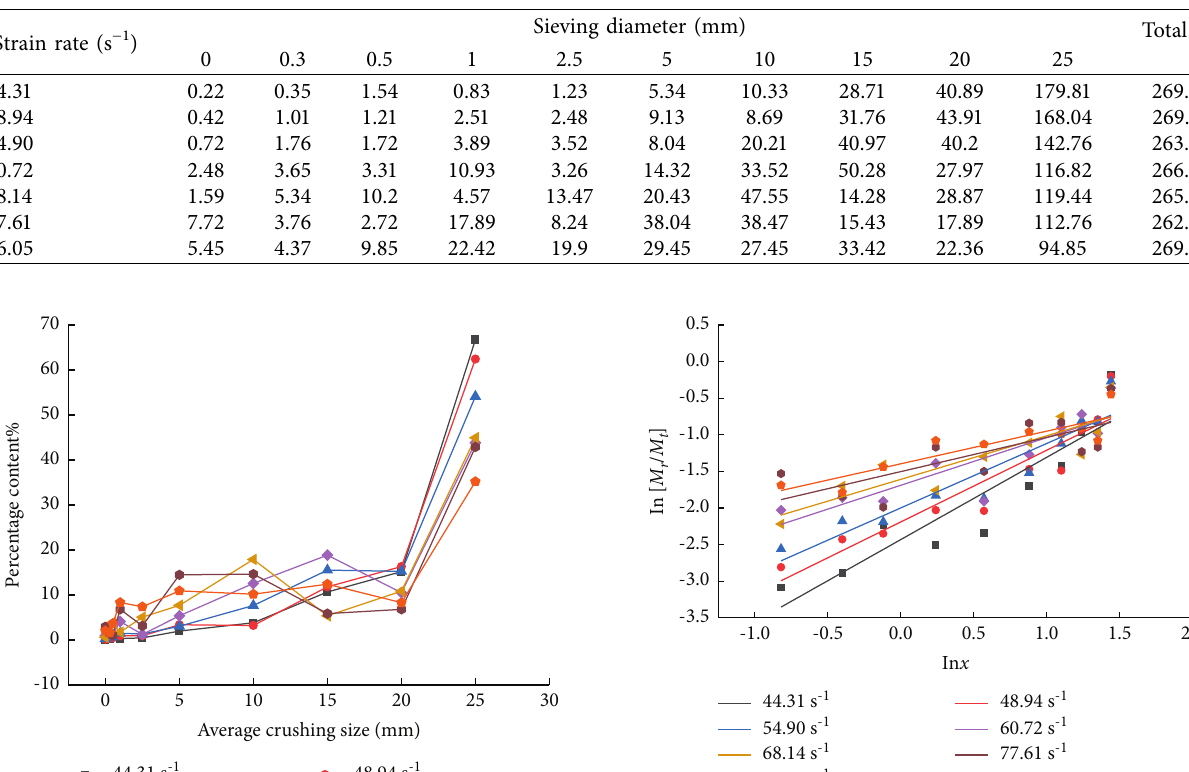
Table 3: Impact test sieve sizes and corresponding weighing masses.